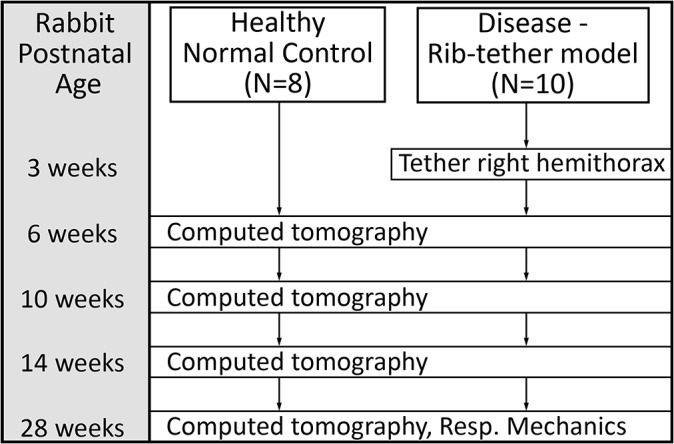
Study overview.Timing of surgery, CT scans, and respiratory mechanics testing relative to post-natal age of rabbits are indicated.